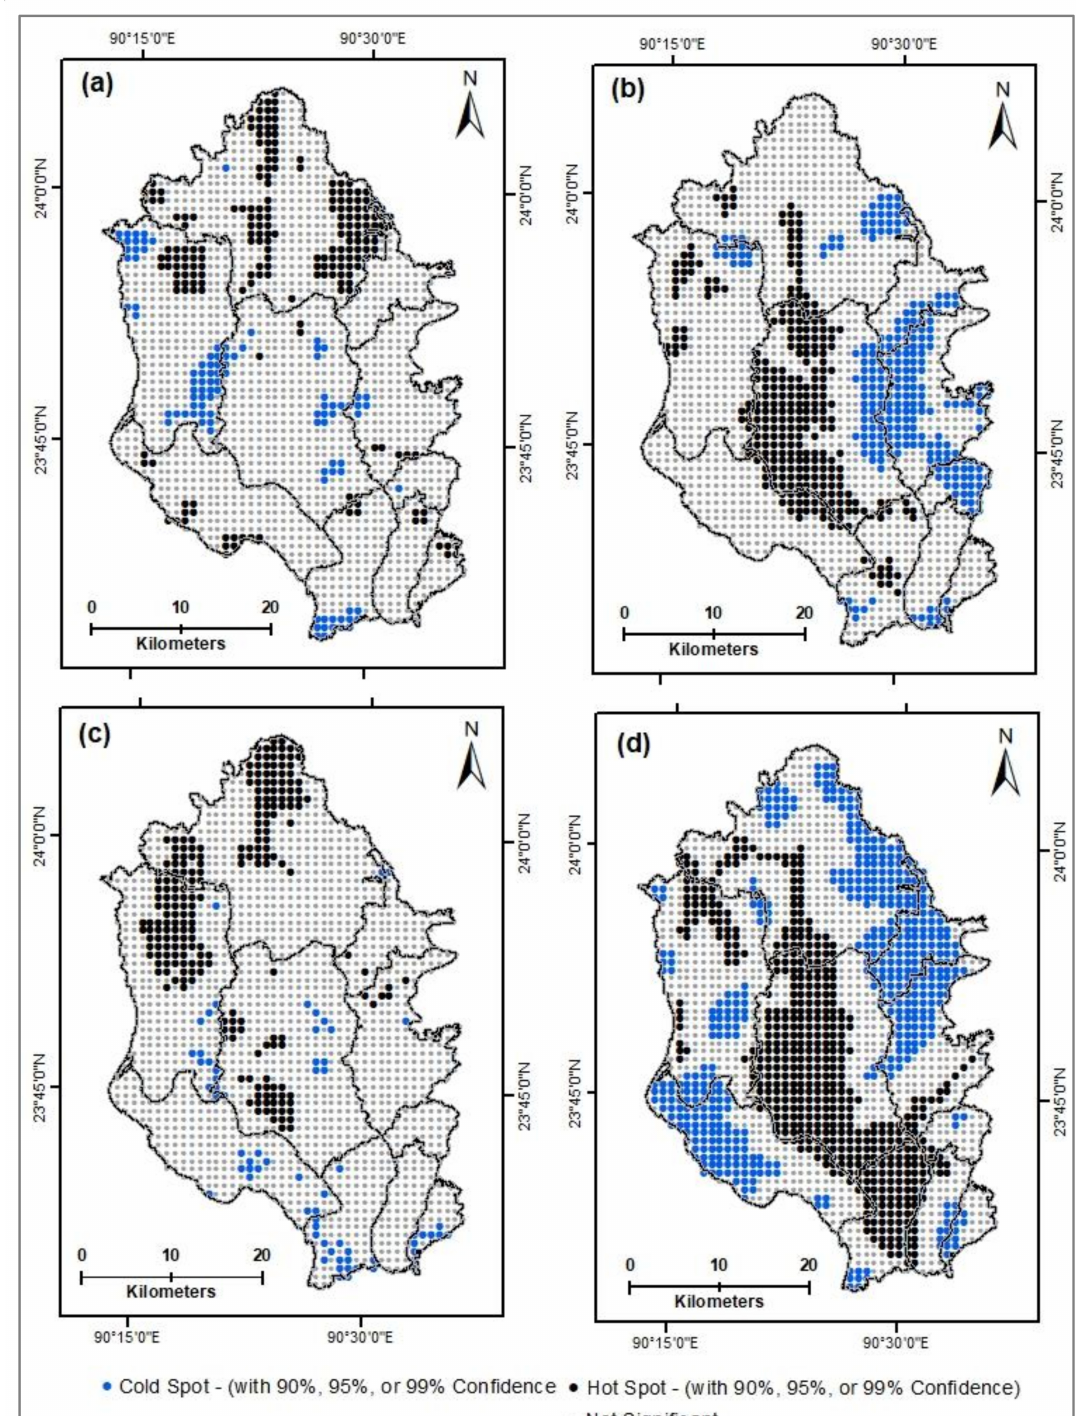
Figure 14. ( a ) Hot spot analysis of the aggregate population growth rate (APGR) mapping; ( b ) hot spot analysis of the standard deviation of the average likelihood of poverty (ALP); ( c ) hot spot analysis of elevation pattern derived from the SRTM global DEM data [43]; ( d ) Hot spot analysis of the fuzzy linear urban membership function set image of